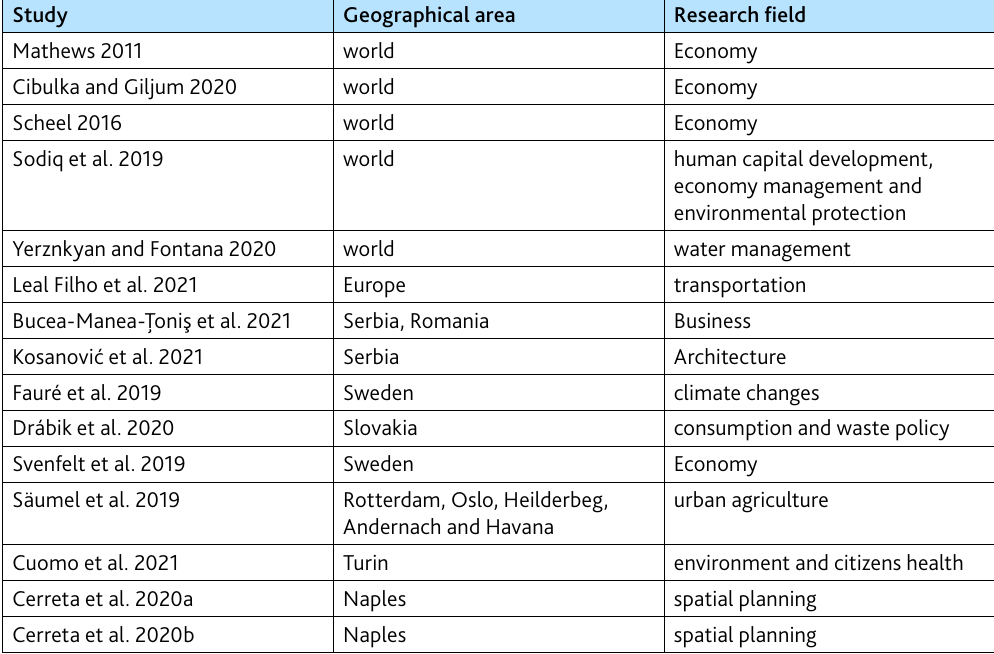
Table 1. Studies of urban sustainable development identified in this literature